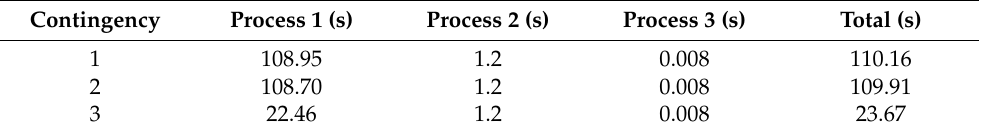
Table 9. The processing time of the proposed